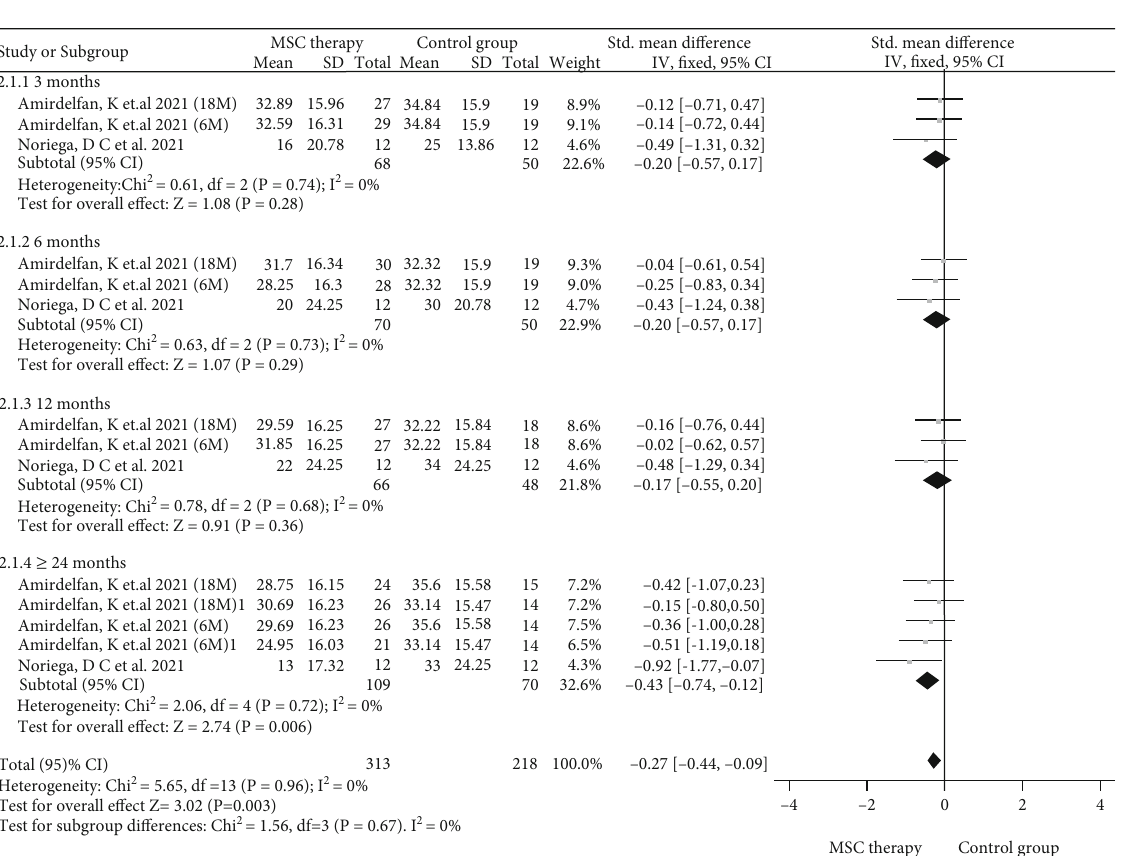
Figure 4: Forest plot of ODI scores between MSC therapy and control